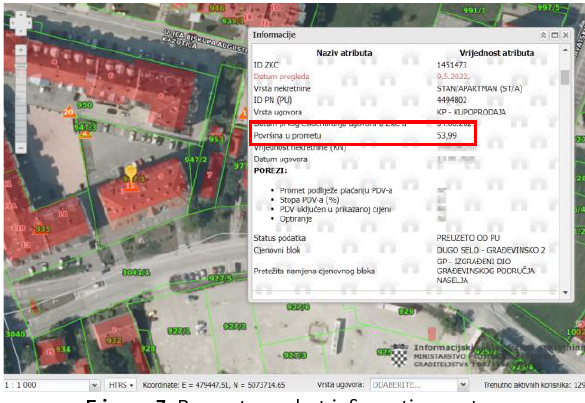
Figure 7. Property market information system